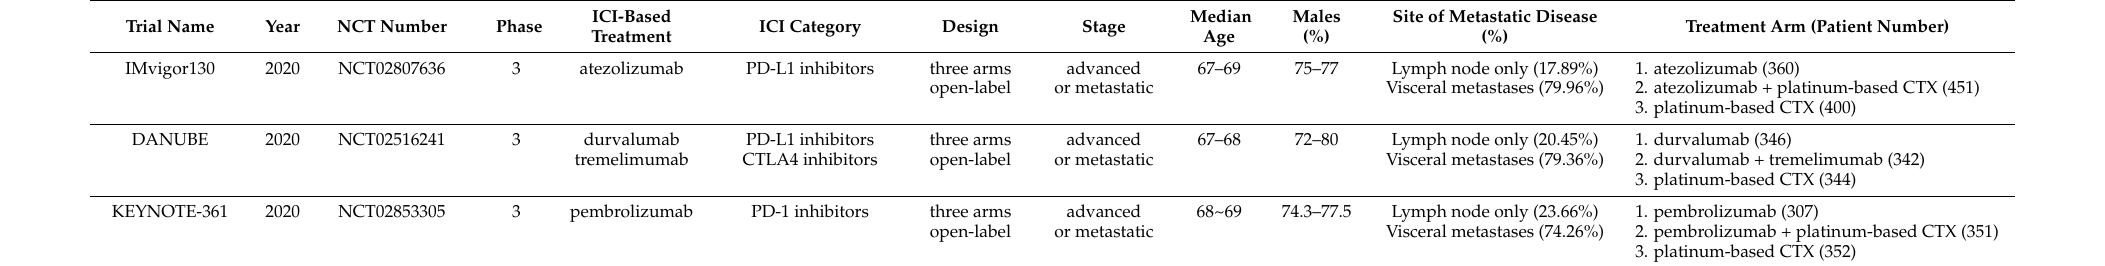
Table 1. Characteristics of the included